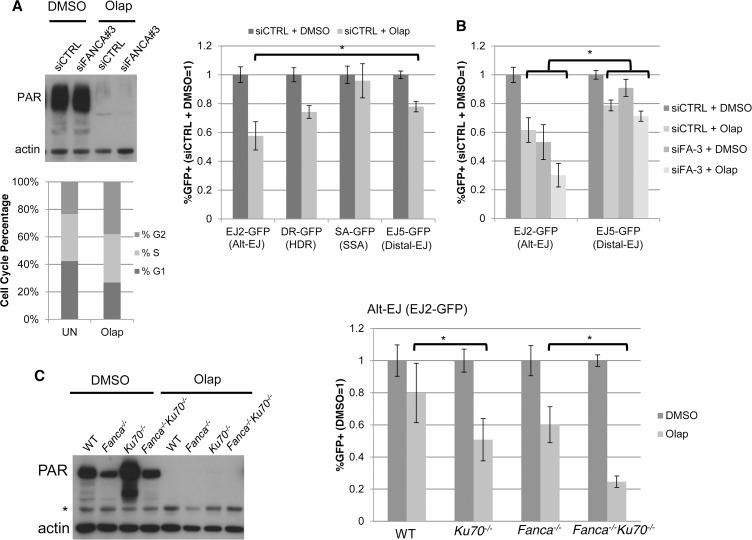
PARP inhibition causes a decrease in Alt-EJ that is enhanced by Ku70 loss.(A) PARPi treatment (Olaparib) causes a specific decrease in Alt-EJ, compared to Distal EJ. Shown are the immunoblot signals for PARylated protein and actin after treatment of U2OS cells with 5 μM of the PARPi Olaparib (2 days). Also shown is the cell cycle profile of siCTRL treated U2OS cells incubated with 5μM Olaparib (Olap), or mock treated (UN) prior to BrdU labeling and PI staining as in Fig. 2C. The U2OS reporter cell lines described above were transfected with the I-SceI expression vector and treated with 5 μM Olaparib (Olap) or vehicle (DMSO). Shown are the %GFP+ cells for each reporter relative to vehicle treatment (DMSO). *P<0.0001 distinct from the effect on Distal-EJ (n = 13). (B) Effect of PARPi on Alt-EJ is approximately additive with loss of FANCA. Shown are GFP+ frequencies for U2OS cells treated with an siRNA targeting FANCA (siFANCA-3) or siCTRL, and subsequently examined as in A, relative to siCTRL/DMSO treated cells. *P<0.0001 distinct from the effect on Distal-EJ (n≥8). (C) Loss of Ku70 enhances the effect of PARPi on Alt-EJ in mES cells. Shown are immunoblot signals for PARylated protein and actin for WT, Fanca−/−, Ku70−/− and Fanca−/−Ku70−/− mES cells treated with Olaparib (2 μM, 2 days) or vehicle (DMSO). *indicates nonspecific band. Each of these mES cells with the EJ2-GFP reporter were transfected with I-SceI and treated with 2 μM Olaparib (Olap) or vehicle (DMSO). Shown is the frequency of %GFP+ cells relative to vehicle treated (DMSO). *P≤0.001 (n≥9).